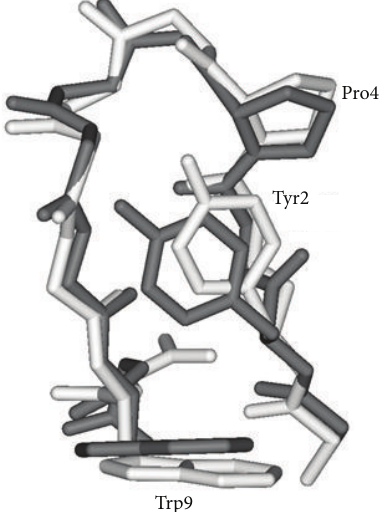
Figure 7: The structure of chignolin with the smallest all-atom RMSD (1.3 ˚A) obtained by the SAAP-MC simulation at 300K in water (white) superimposed on the reference native structure